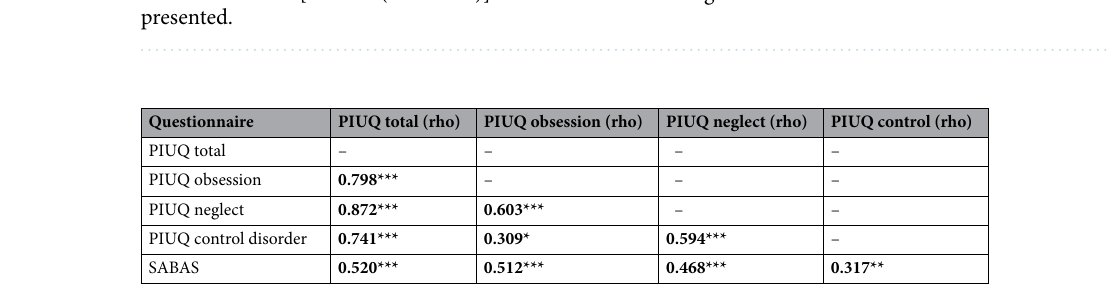
SABAS scores showed positive associations with the FCs between right amygdala and the right posterior SMG, right anterior MTG, left SFG and bilateral FP after Benjamini–Hochberg correction (Table 5).